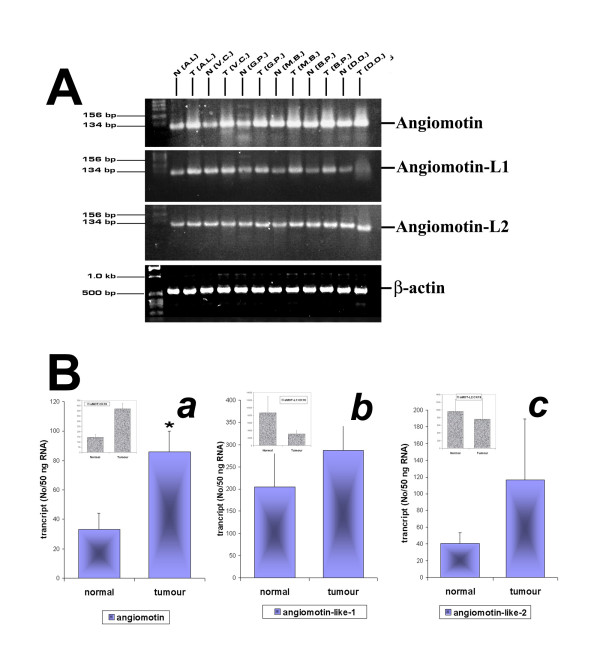
Expression of angiomotin and angiomotin like transcript in normal and tumour tissues using conventional RT-PCR (A) and quantitative real-time PCR (B). A: paired normal (N) and tumour (T) tissues from selected patients. B: levels of the respective transcript and the transcript:CK19 ratio (inserts) from all the samples (normal n = 32 and tumour n = 120). * p < 0.05 vs tumours.